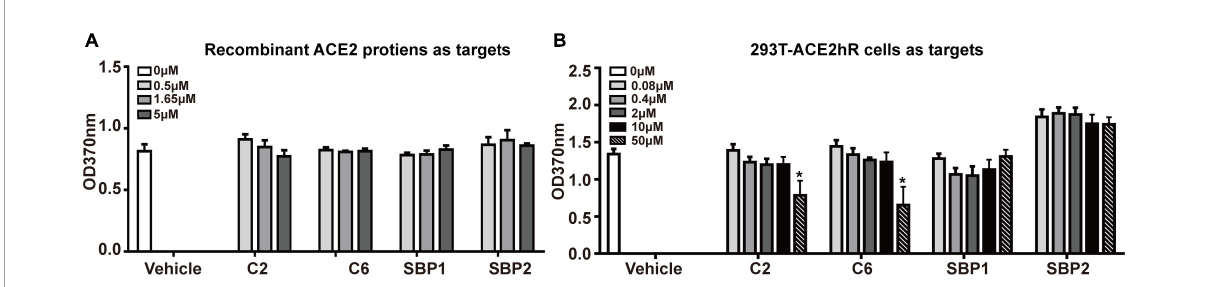
FIGURE3 The potential blocking effect of peptides on the binding of S-trimer onto cellular or soluble angiotensin-converting enzyme 2 (ACE2). (A) The enzyme-linked immunoassay (ELISA) was applied to assess the blocking ability of synthetic peptides C2 and C6 at binding between ACE2 molecules and S-trimer protein, and the peptide SBP1 was used as positive control and peptide spike-binding peptide 2 (SBP2) as the negative control. (B) ELISA was applied to assess the blocking ability of synthetic peptides C2 and C6 at binding between 293T-ACE2hR cells and S-trimer protein. The peptide SBP1 was used as a positive and peptide SBP2 as the negative control. * p < 0.05, vs. vehicle, all by Student’s t